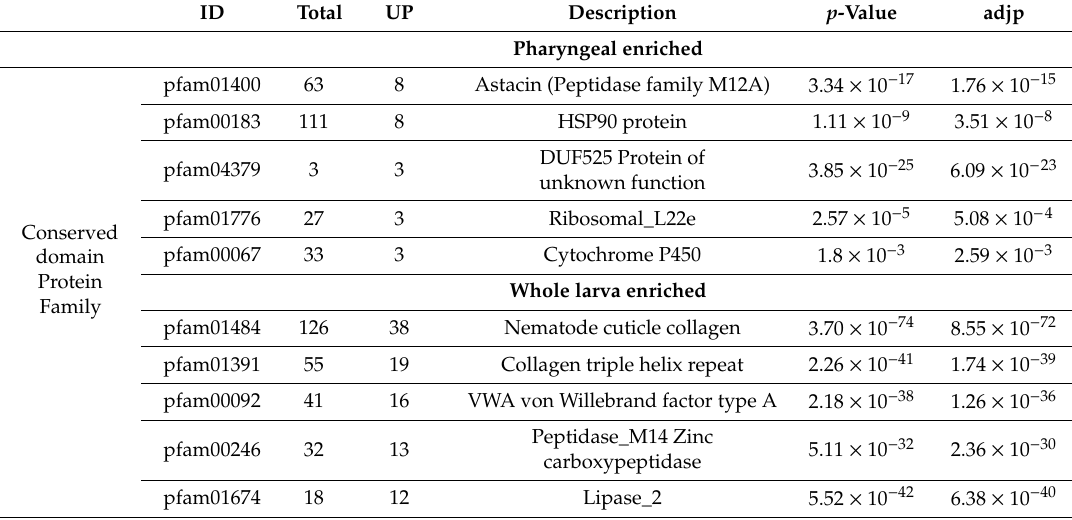
Table 3. Top five HA enriched transcripts. List of the five most enriched groups of transcripts in HA classified according to the conserved protein domain family and to the gene ontology (biological process and molecular function), with indication of total number of transcripts recovered, of enriched ones, and of p -value and adjusted p -value (FDR).